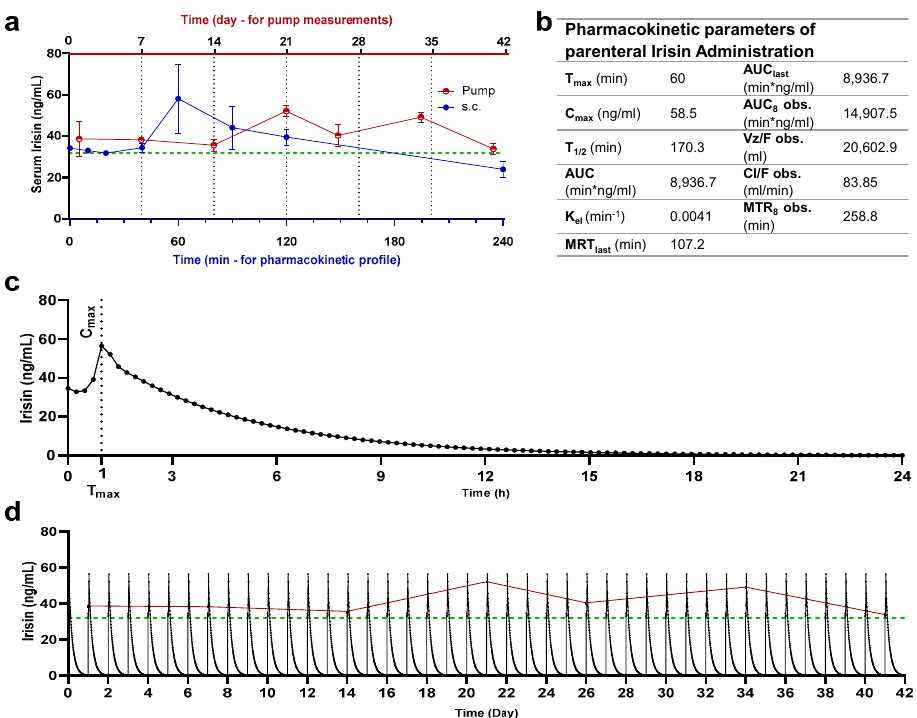
Figure 3. Relative and simulation-generated pharmacokinetic profiles of irisin. ( a ) Serum sampling and irisin quantification of irisin administered via the osmotic pump (upper x -axis—red) and subcutaneous route (bottom x -axis—blue) in Sprague Dawley rats, as well as baseline levels measured in control animals (dashed line—green). Irisin quantification was made at specific time intervals after administration: weekly during 42 days of osmotic pump release for rats receiving irisin via a pump and 4 h from the subcutaneous injection (min); ( b ) pharmacokinetic parameters of irisin in Sprague Dawley rats receiving irisin via the subcutaneous route; ( c ) simulated kinetic profile of single-dose subcutaneous administration; ( d ) repeated for 42 days with pump readings plotted with baseline levels of control animals (dashed line—green) and pump-released irisin levels (continuous line—red).